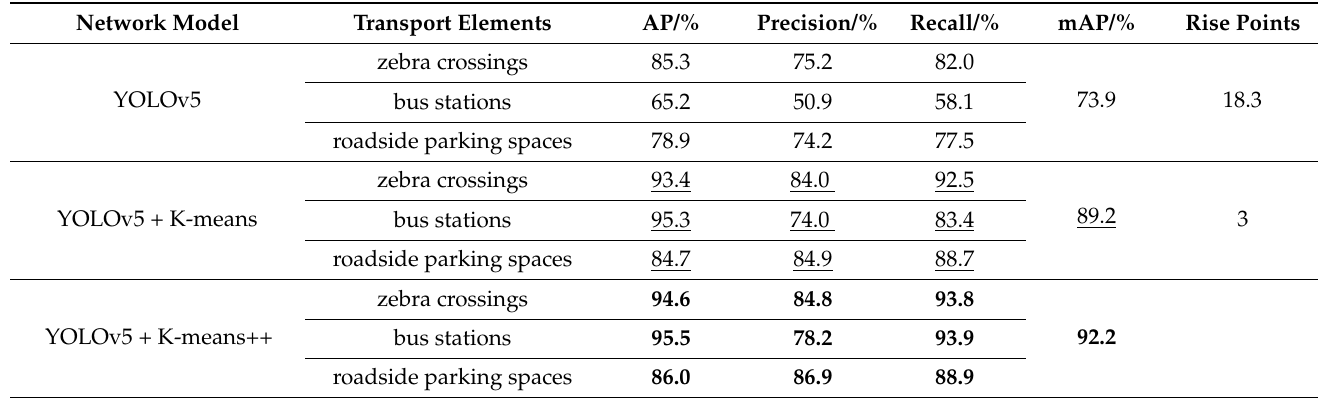
Table 4. Detection results of different